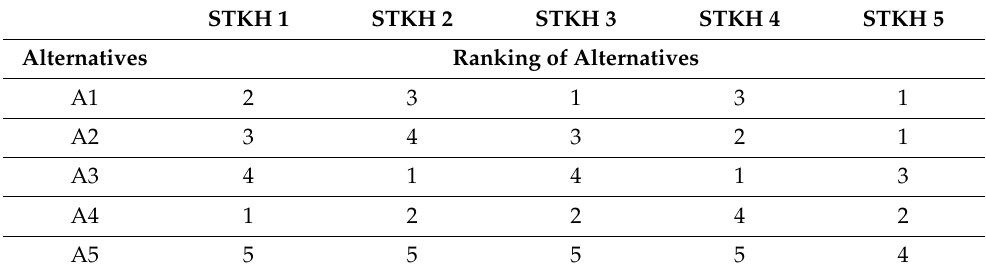
Table 5. Ranking of alternatives.